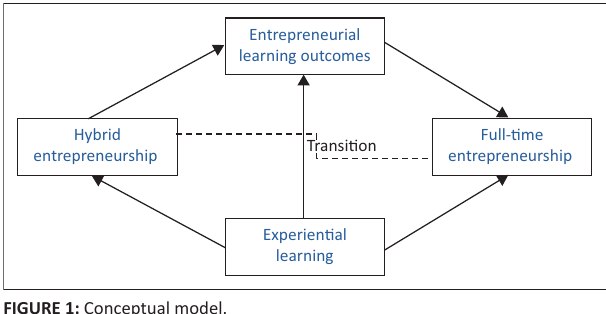
FIGURE 1: Conceptual